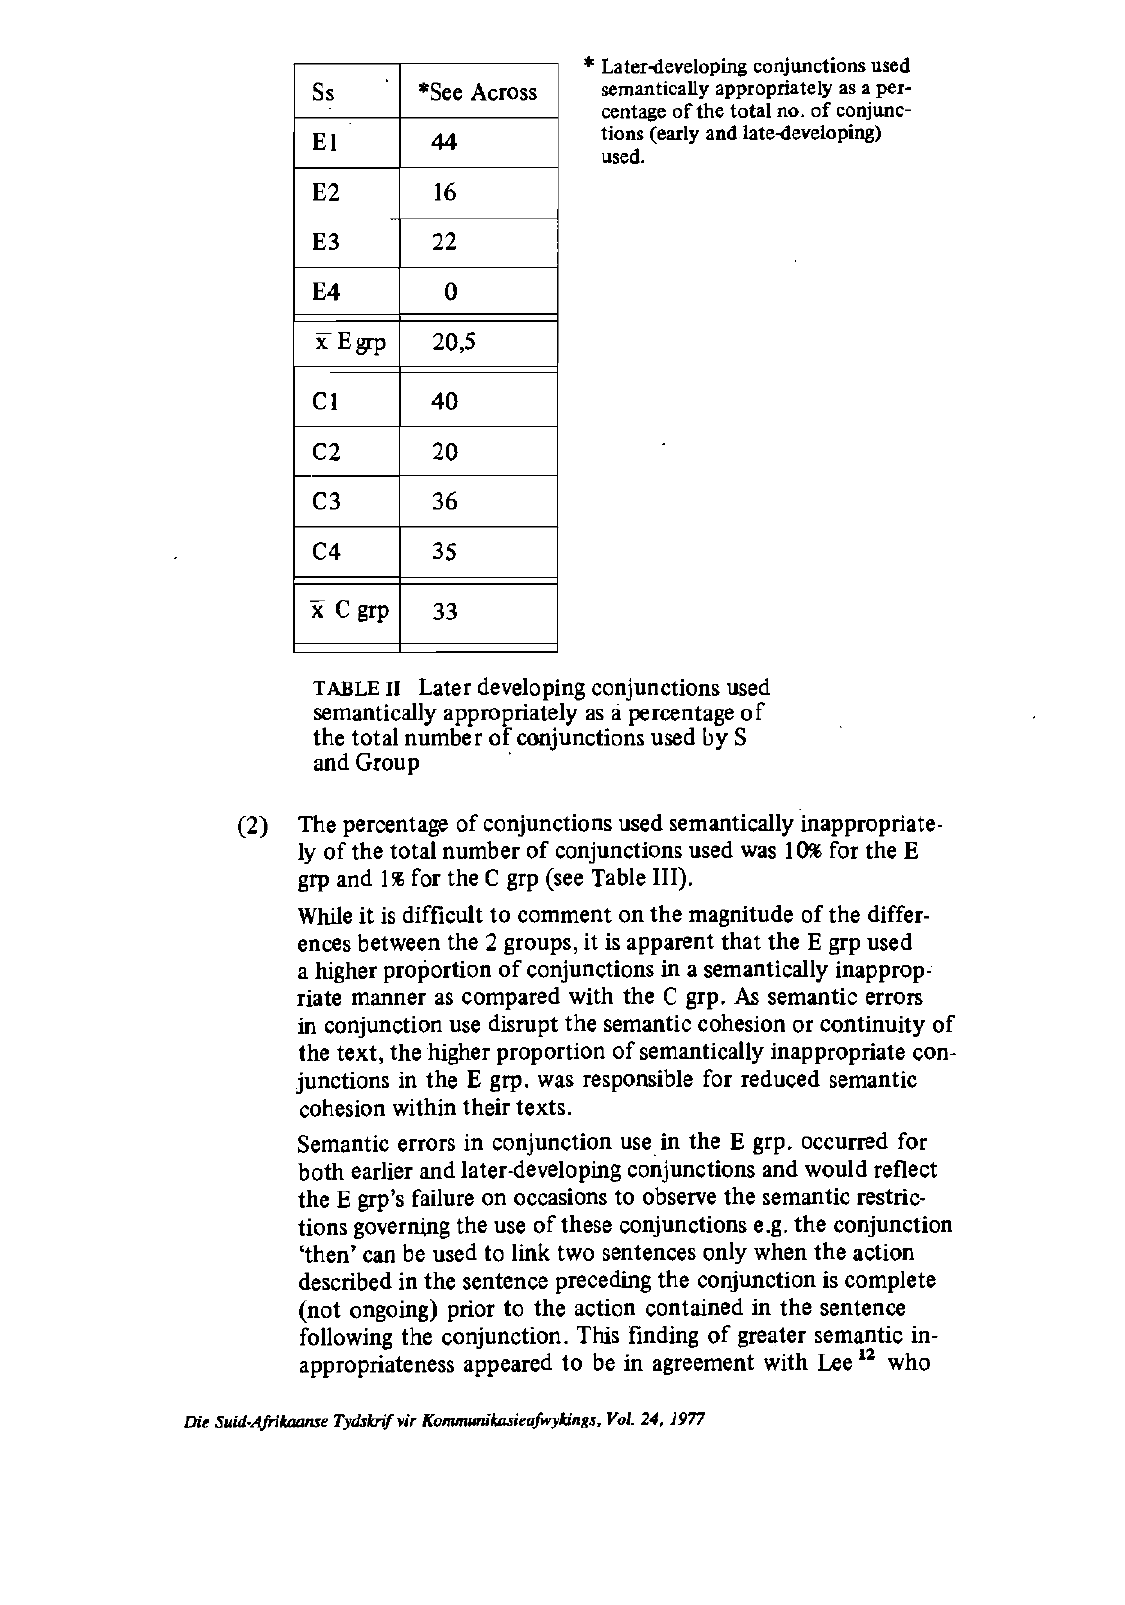
TABLE II Later developing conjunctions used semantically appropriately as a percentage of the total number of conjunctions used by S and